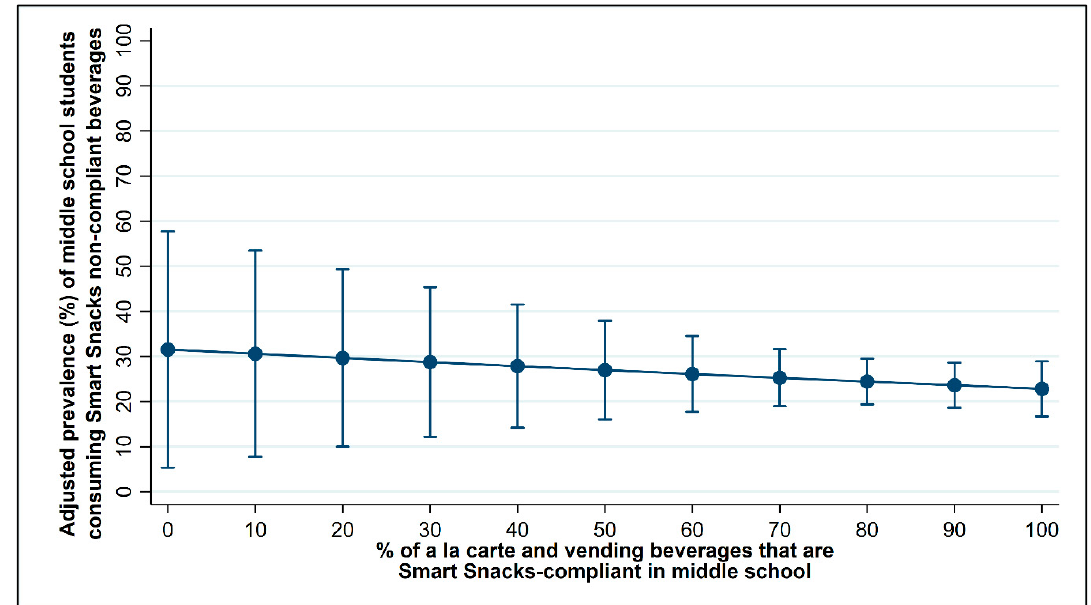
Figure 2. Adjusted prevalence of middle school student consumption of non-compliant beverages in school by the percentage of compliant beverages sold in school.